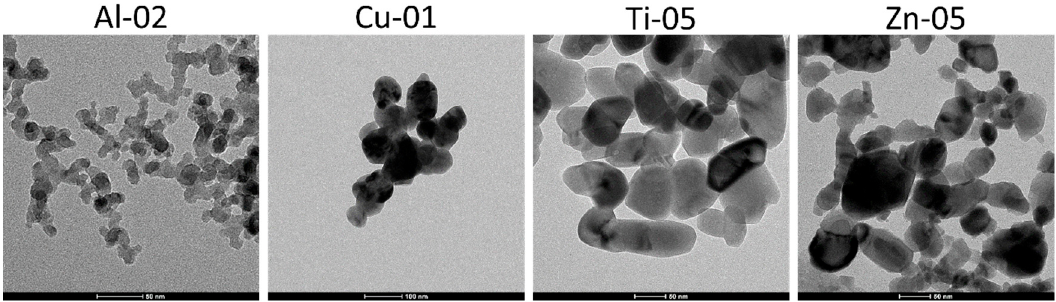
Figure 4. Representative TEM images for four metal oxides nanomaterials. Images for all samples are provided in the Supplementary Material.